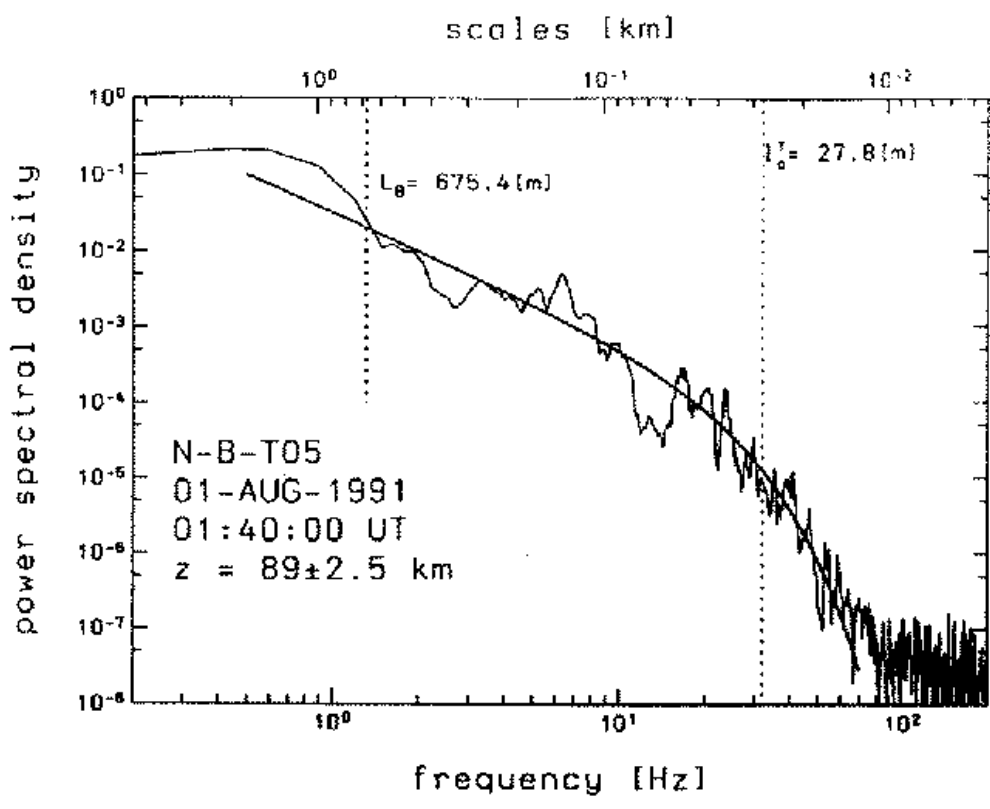
Fig. 1. Power spectrum of relative density fluctuations together with Tatarskii’s (1971) theoretical model (from Lubken, 1992).